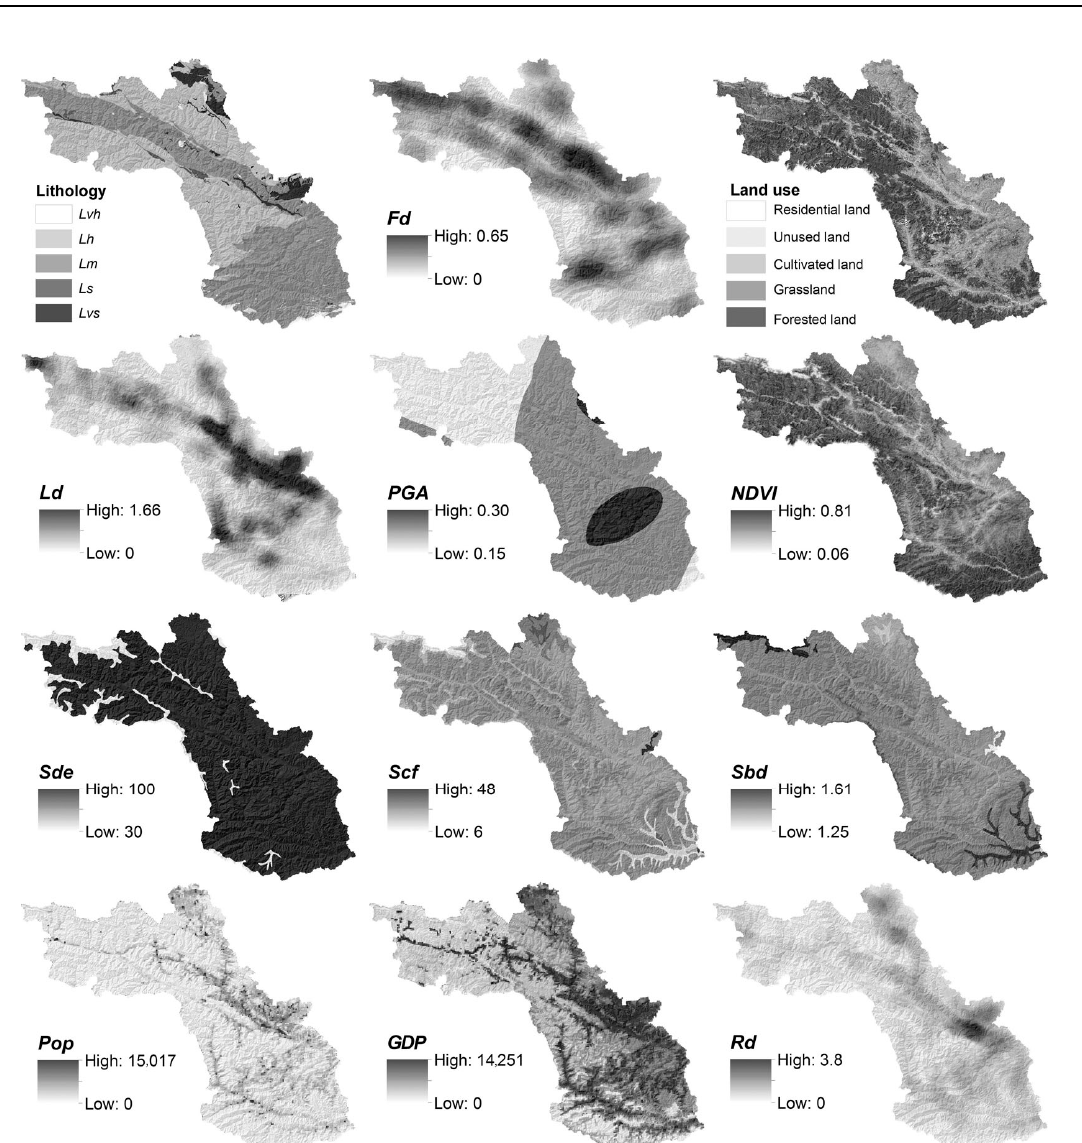
Figure 2. Distribution of factors related to material conditions. The linear density of faults was calculated using the line density tool in GIS software ( Fd , Figure 2), and the average value in each catchment was determined to analyze the impact of faults on debris flows.